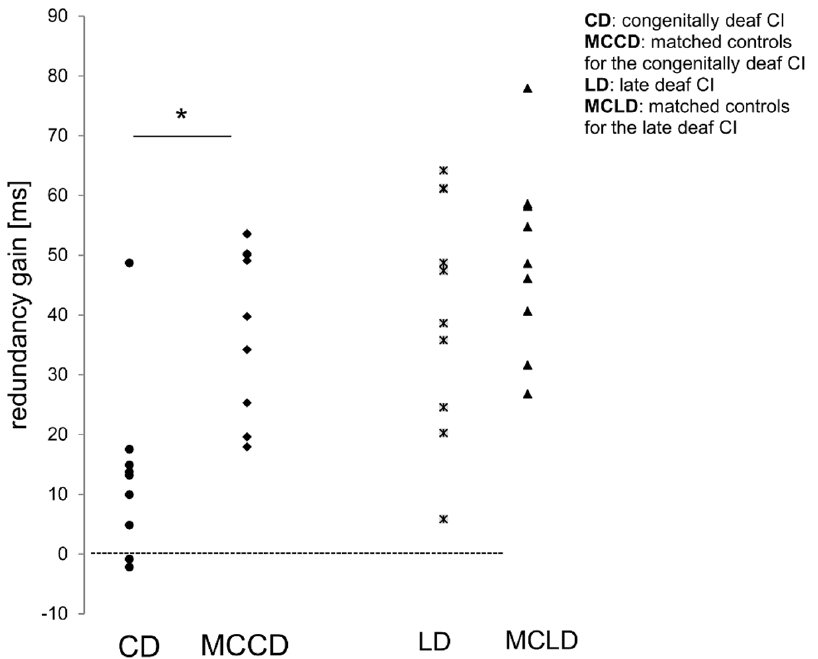
Figure 3. Redundancy gains (in ms). Redundancy gains for each participant (in ms), computed as the difference between the mean reaction times of bimodal stimuli and the fastest unimodal stimuli. Note that congenitally but not late deaf CI recipients showed lower redundancy gains compared to their matched controls.